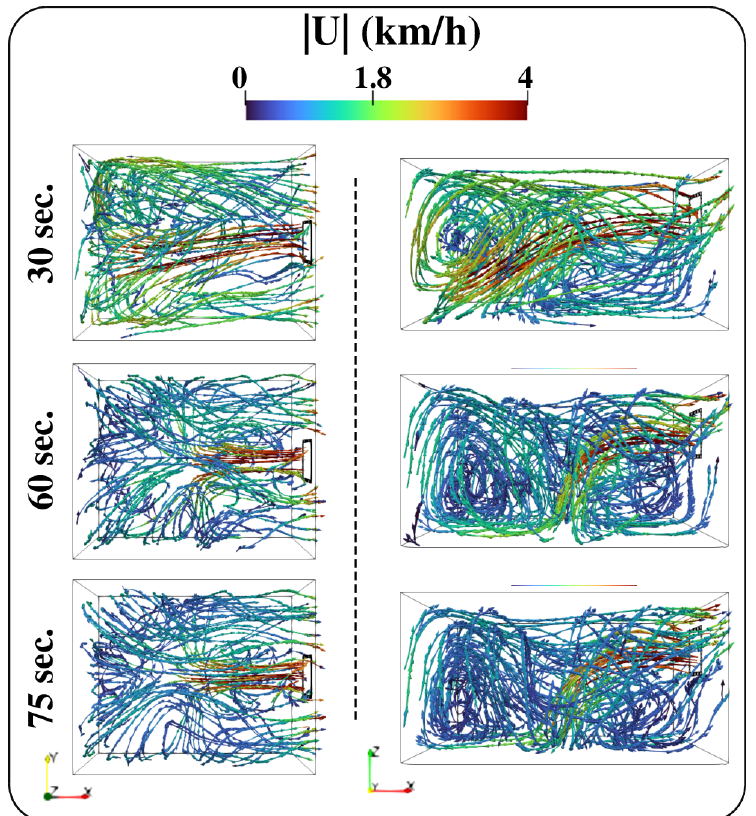
Figure 2. Streaklines indoors at different times coloured by the velocity magnitudes. Case: Natural ventilation due to a negligible wind speed outdoors U = 0 and a lower outdoor temperature, walls-particles-interaction: unstick . Left hand side Column: XY-plane perspective view; Right hand side Column: XZ-plane perspective view.